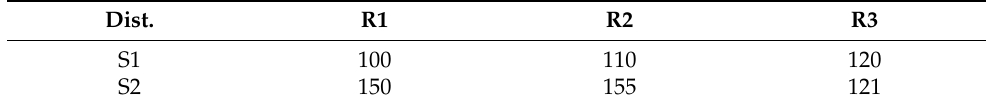
Table 4. Distance between the suppliers and retailers.